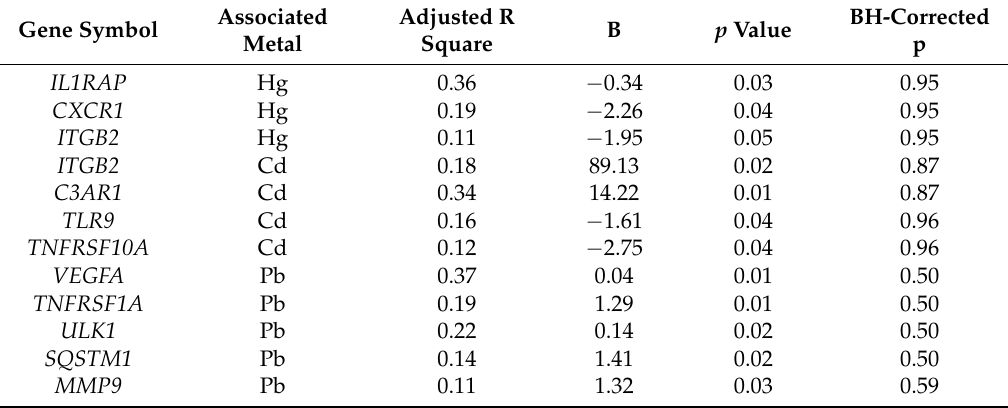
Table 2. Whole blood expression of genes associated with blood Hg, Cd, or Pb levels (non-adjusted p <